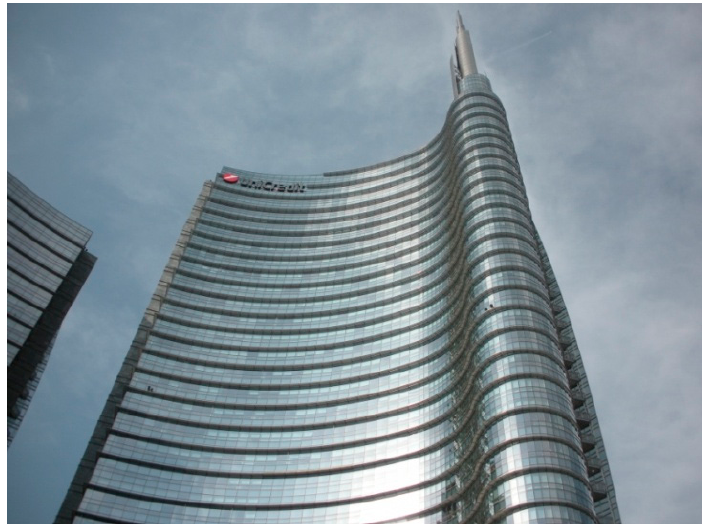
Figure 12. Urban transformation in